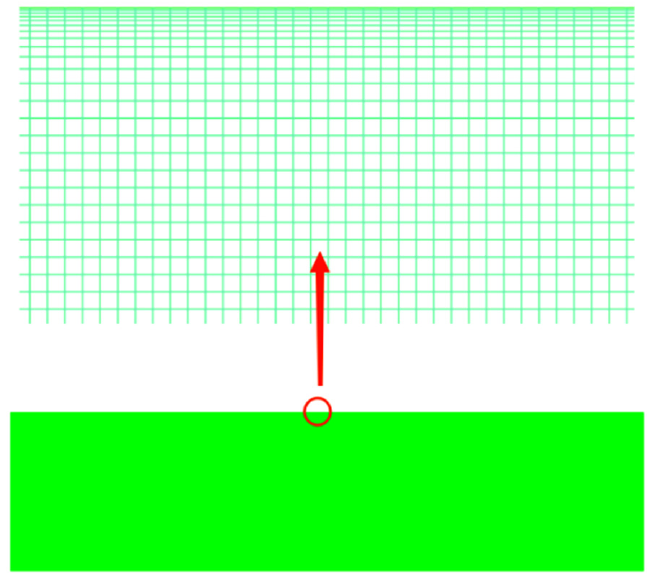
Figure 2. Schematic diagram of grid division.